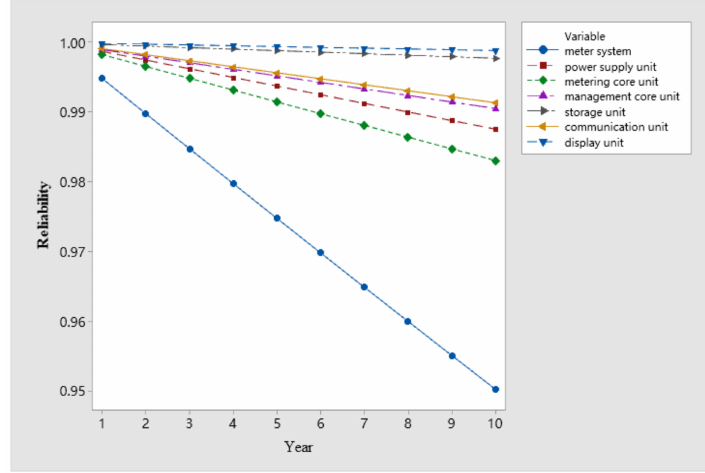
Figure 13. Dynamic reliability diagram of the smart meter.